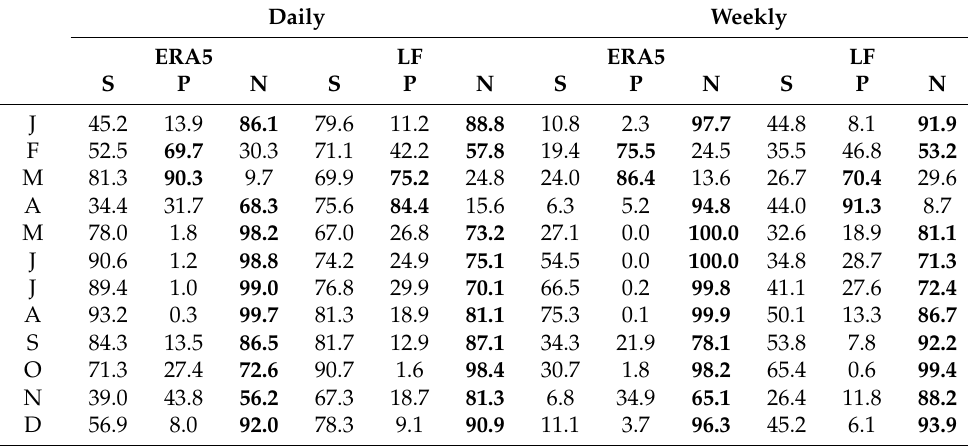
Table 3. Monthly results of the percentage of significant (S), positive (P), and negative (N) trends at the daily and weekly scales for the soil moisture anomalies. Maximum trend percentage values are in bold.